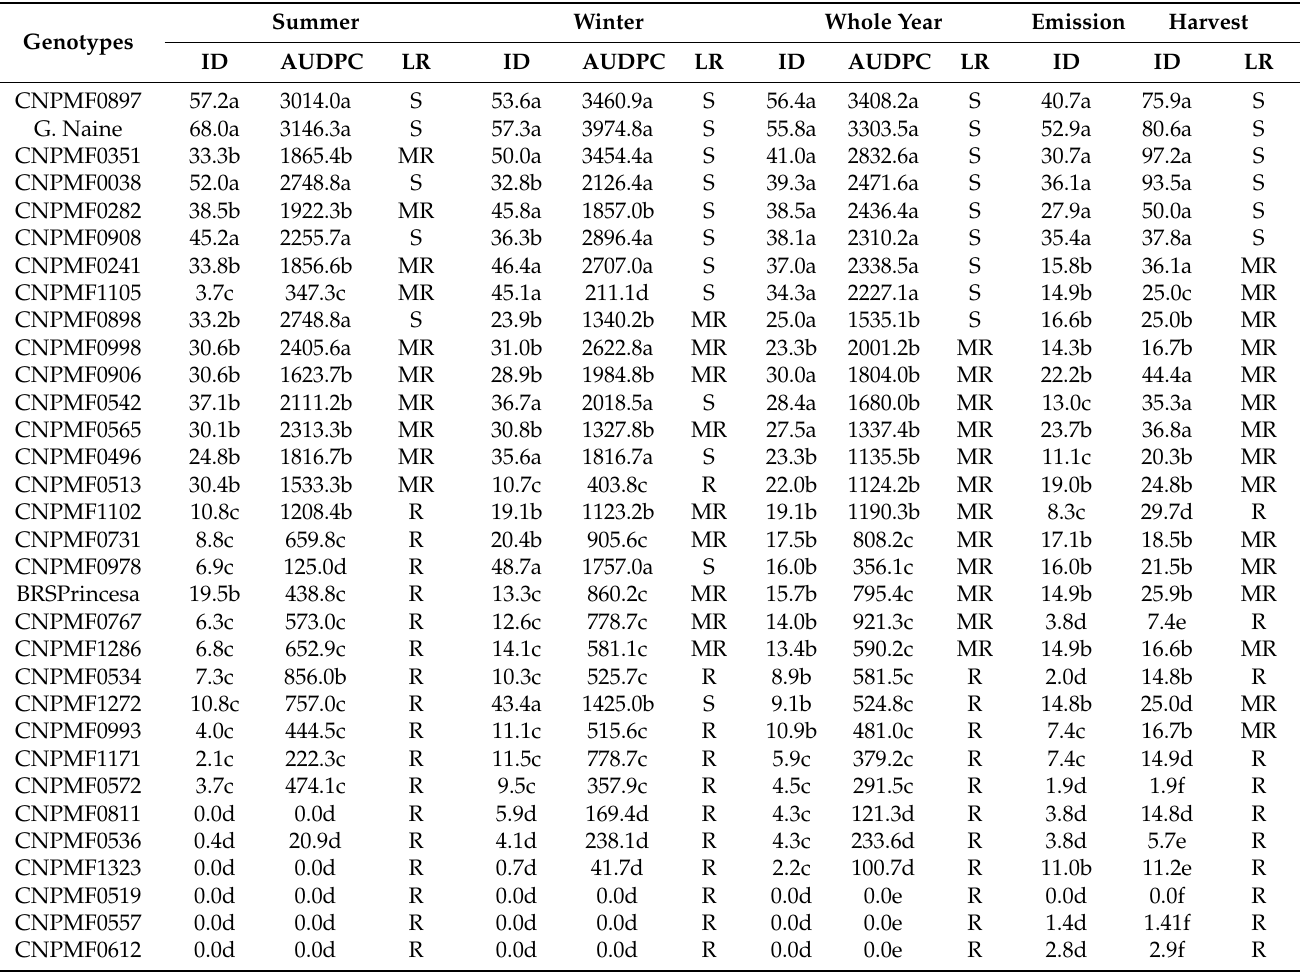
Table 2. Levels of resistance to black Sigatoka among the improved diploids and tetraploids hybrids. Embrapa 2021.